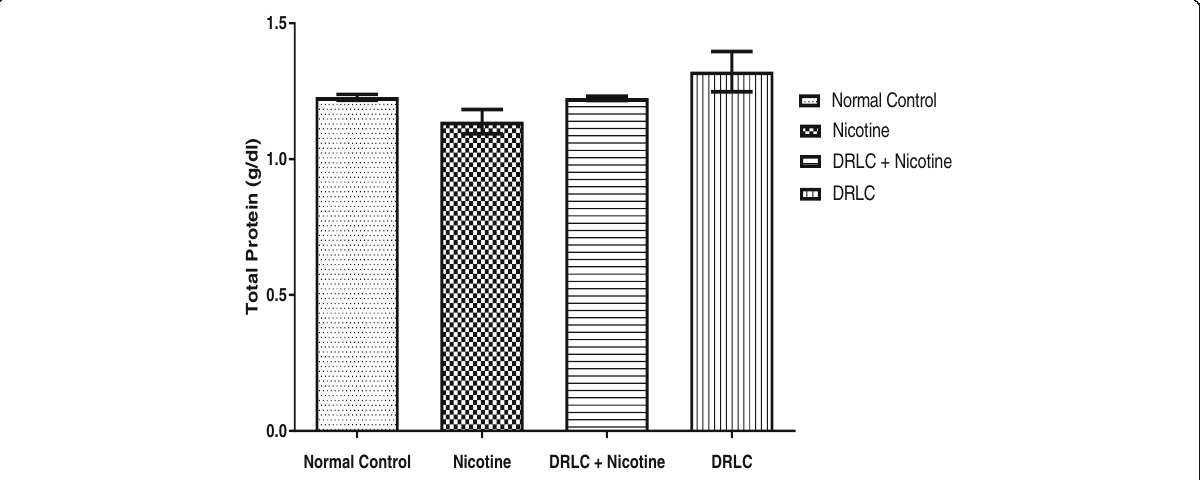
Fig. 6 Charts showing total protein levels in experimental animals. Values are mean ±SEM; N = 5